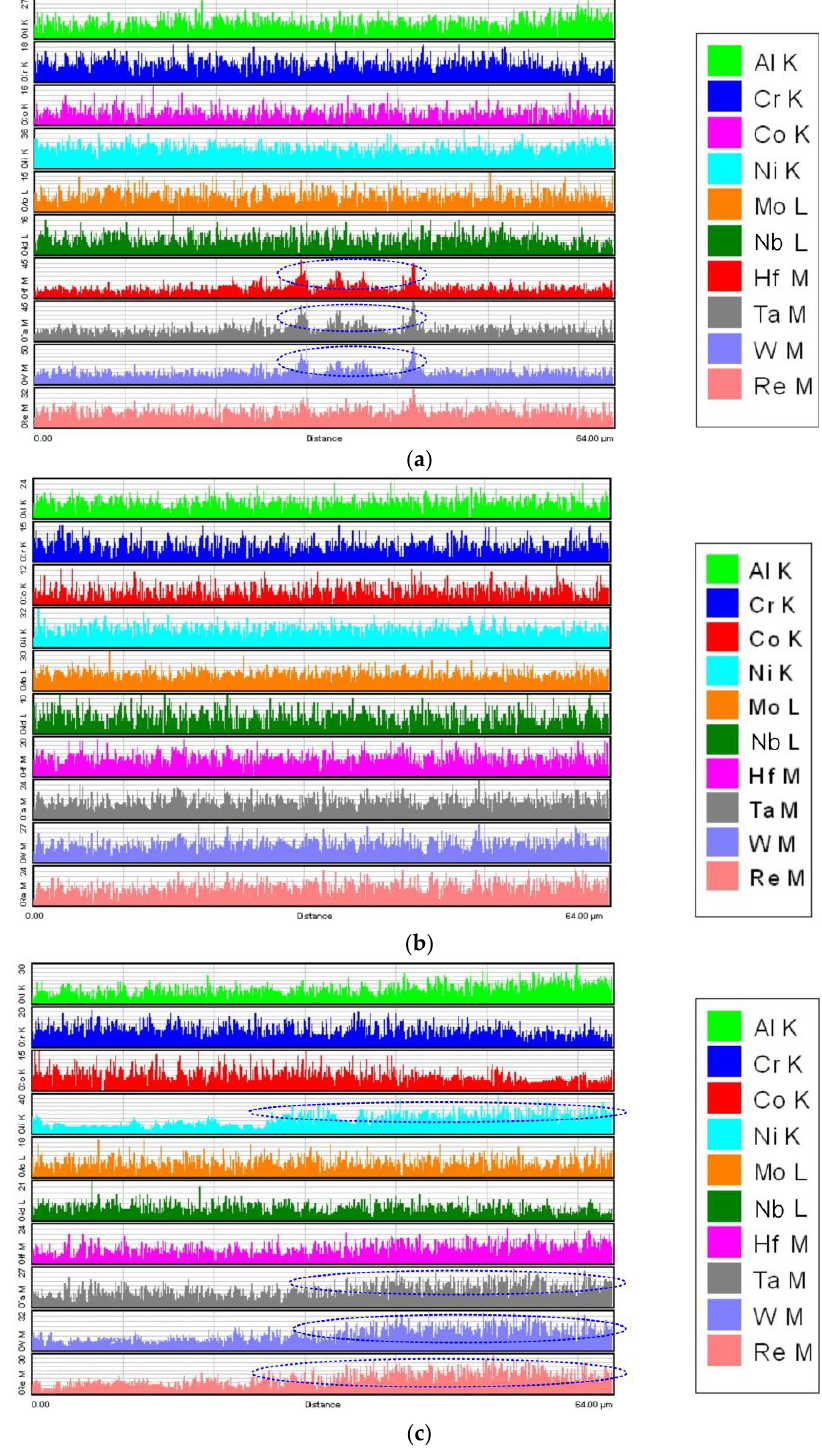
Figure 7. Element distribution along ( a ) line A, ( b ) line B and ( c ) line C scanning by EDS.